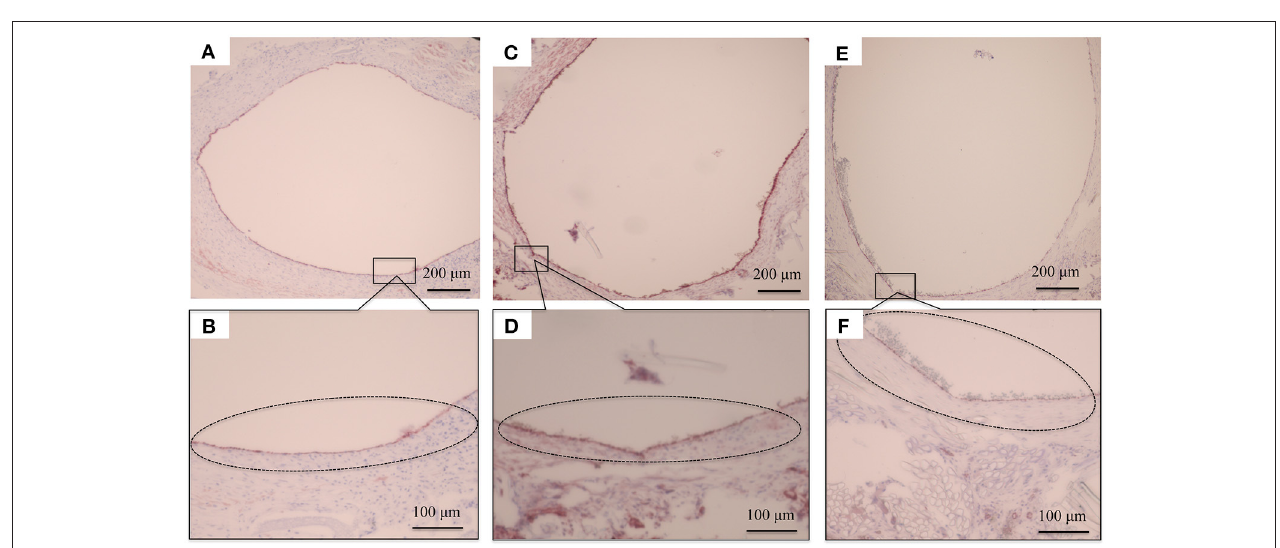
FIGURE 9 | Histopathological photographs of CD31 staining at (A) 2 weeks after implantation and (B) higher magnification. (C) CD31 staining at 4 weeks after implantation and (D) higher magnification. (E) CD31 staining at 12 weeks after implantation (F) and higher magnification. The black circles indicate the vascular endothelial cells adhering to the luminal surface of the